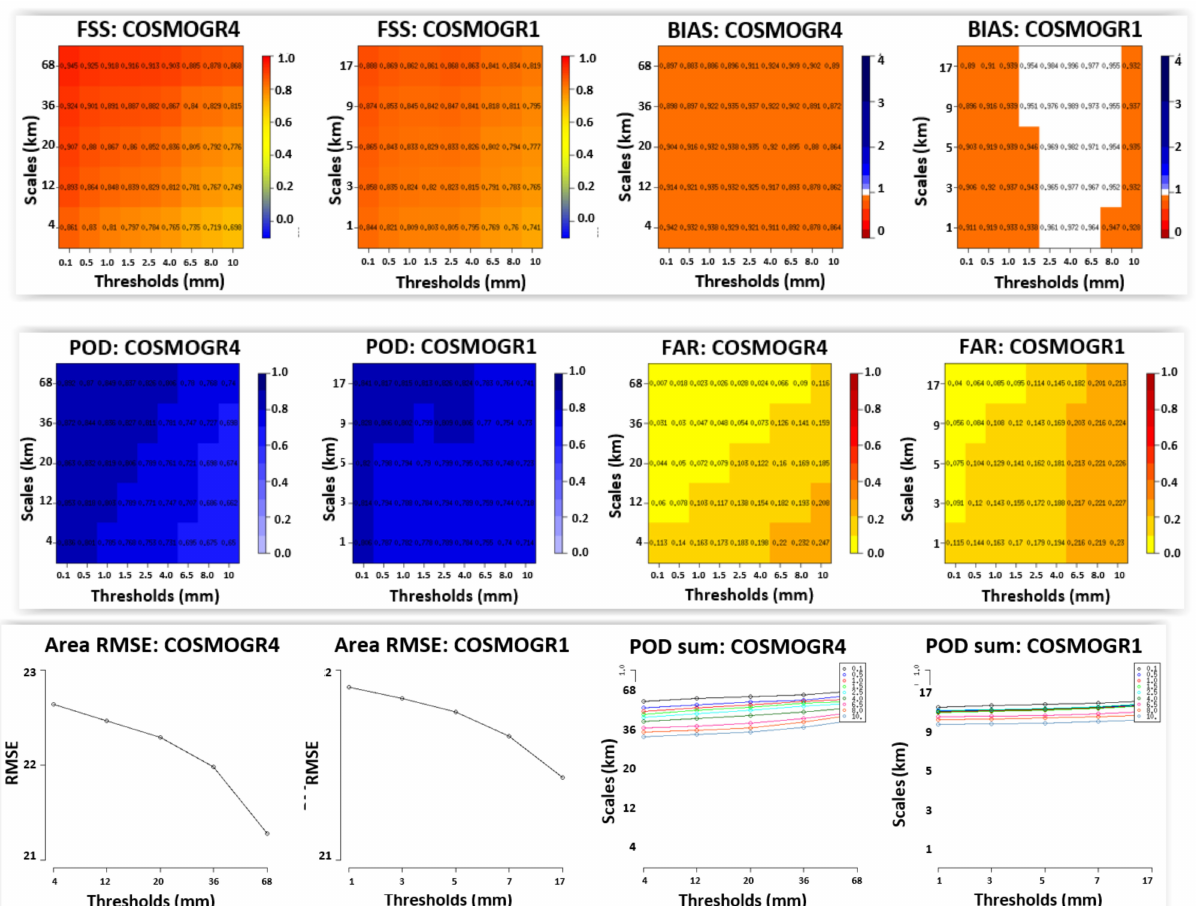
Figure 9. Plots of FSS-BIAS ( first row ), POD-FAR ( second row ), RMSE and summary POD ( third row ) for the 24-h precipitation forecasts of COSMOGR4 and COSMOGR1 for 16–17 July